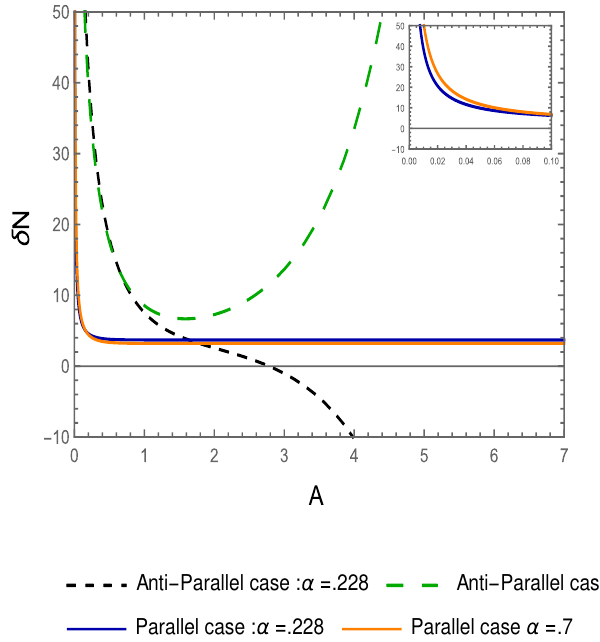
Figure 6 . Parallelly and anti-parallelly accelerating detectors in (1 + 1) dimensions: δ N VS A plot for different fixed values of the coefficient α with ∆ E